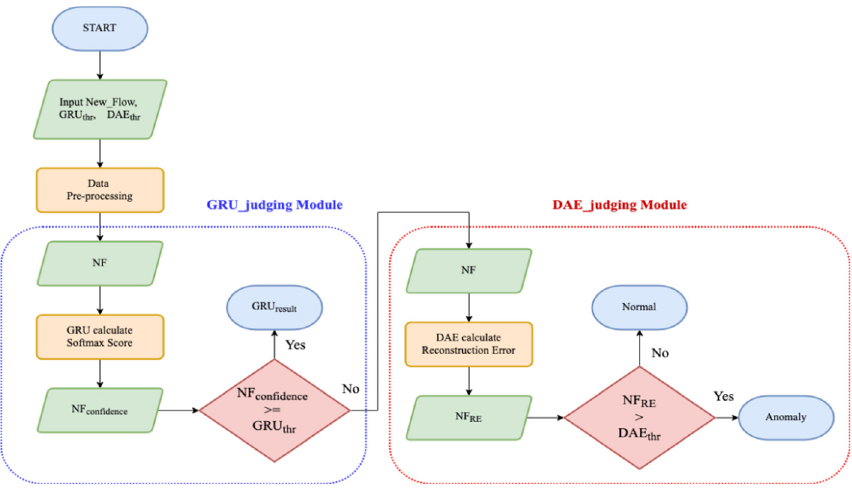
Figure 4. Operational process of the judging mode